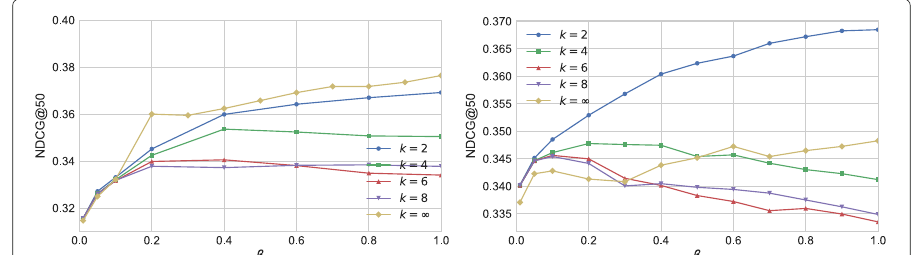
Fig. 13 NDCG@50 performance of temporal Katz centrality as the function of parameter β . Different curves correspond to the different values of k . We set τ = 6 h for the UO17 data, and τ = 3 h for the RG17 data. Left: UO17, Right: